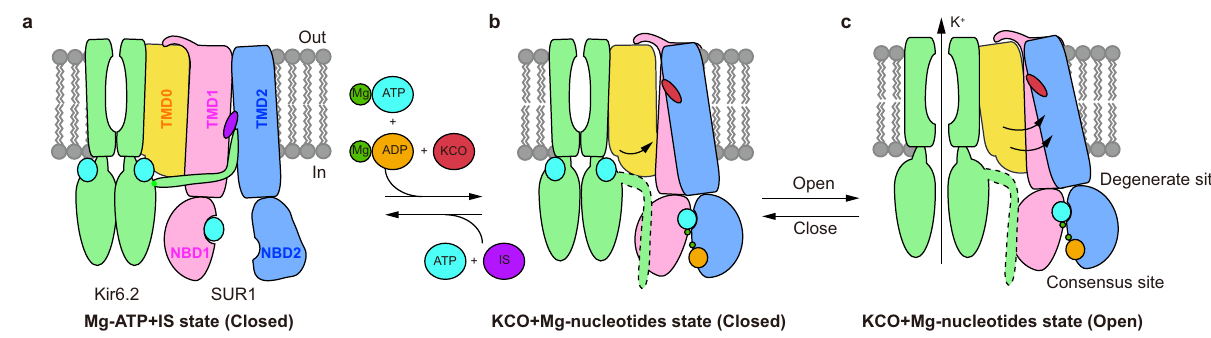
Fig. 6 Model for the K ATP channel activation by Mg-nucleotides and K ATP opener. a – c Side view of the cartoon model of the K ATP channel. For simplicity, a pair of Kir6 subunits and one SUR2 subunit are shown. Kir6, TMD0, TMD1-NBD1, TMD2-NBD2, Mg 2 + , ATP, ADP, insulin secretagogue (IS), and K ATP opener (KCO) are colored in green, yellow, pink, blue, dark green, cyan, orange, purple, and red, respectively. The fl exible KNtp in the Mg-nucleotide and K ATP opener-bound state is outlined by dashed